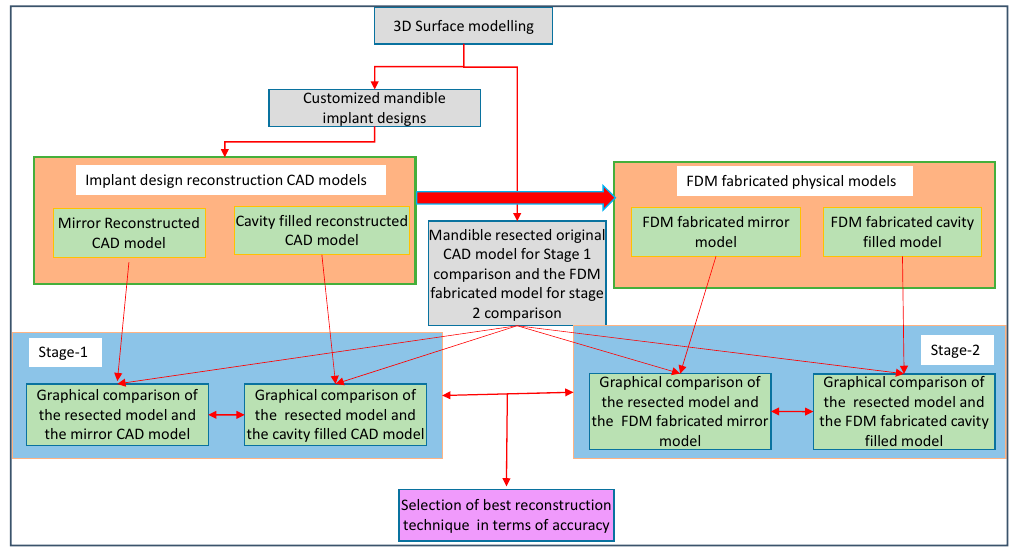
Figure 10. Evaluation of an implant design reconstruction technique using a comparison approach.